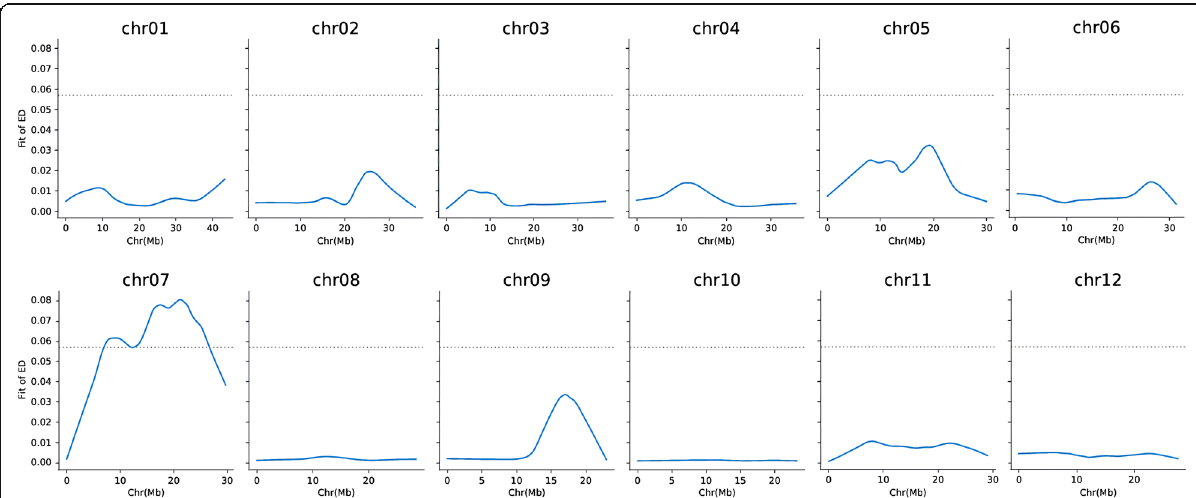
Fig. 5 ED algorithm mapping salt-tolerant QTL. The blue line represents the fitting value of ED, and the dashed line represents the threshold line